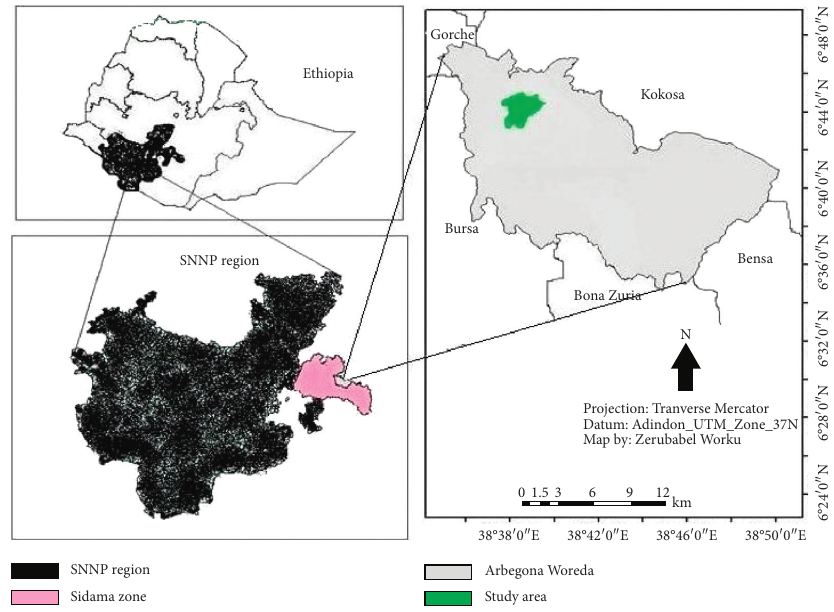
Figure 1: Location map of Geremba Mountain, southern